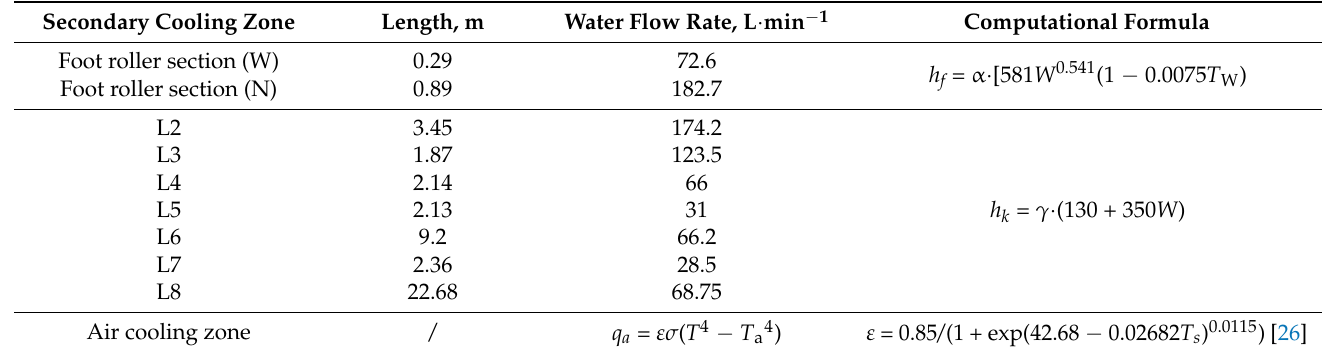
Table 4. Parameters and relevant computational formulas at different sections of the secondary cooling zone.